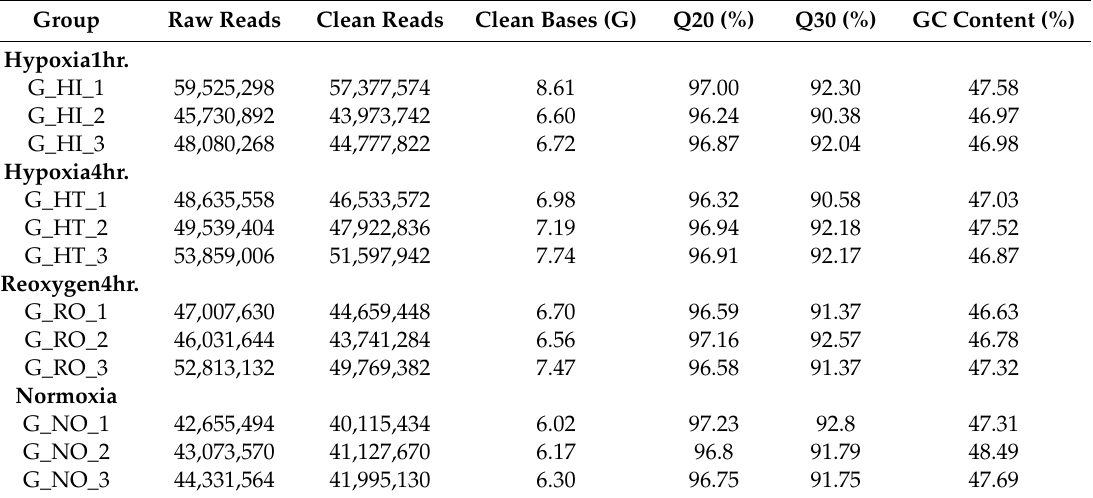
Table 1. Summary of gill transcriptome sequencing